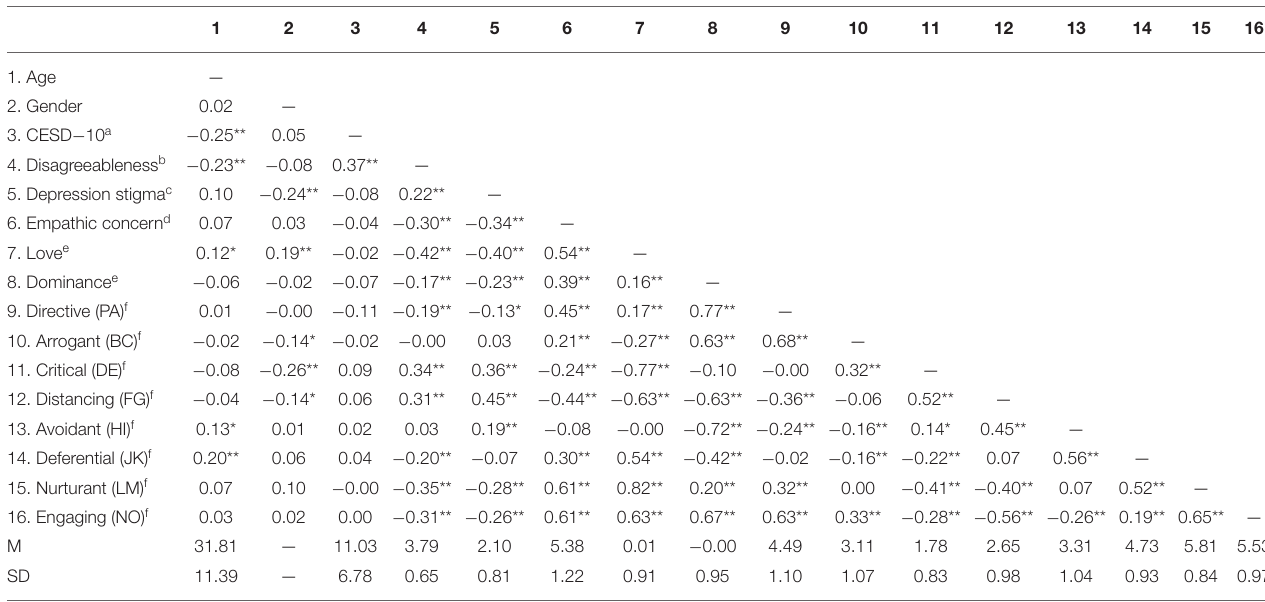
TABLE 5 | Descriptive statistics and correlations in Study